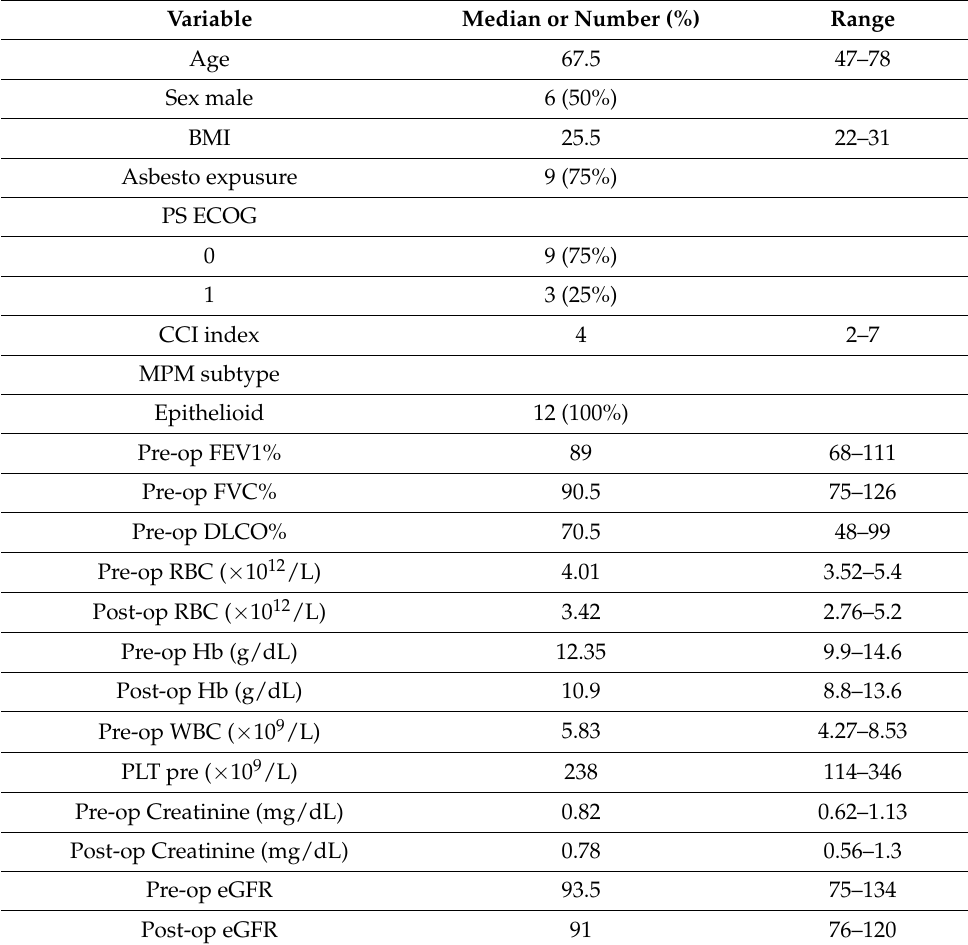
Table 1. Demographic, functional and laboratoristic data.